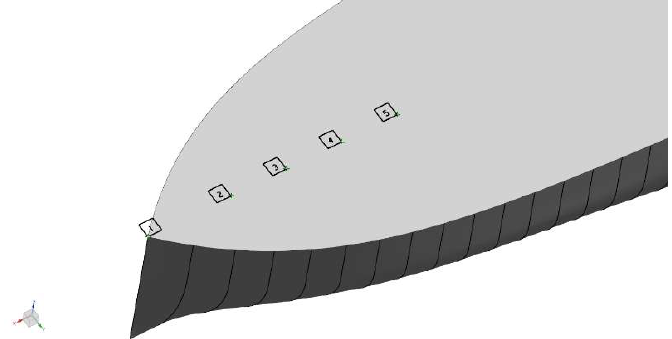
Figure 8. Monitoring points (Point 1 to 5 starting from the bow) on the deck for the pressure